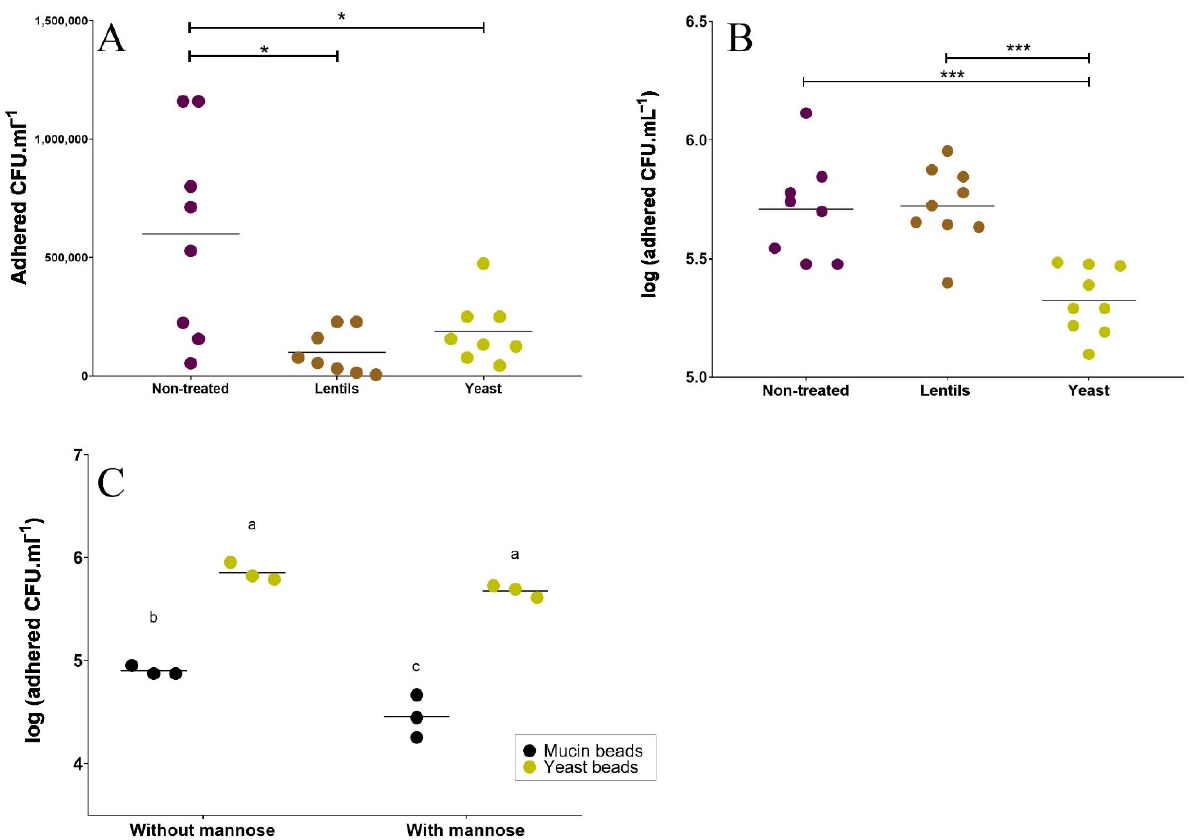
Figure 3. Effects of fiber-containing products on ETEC adhesion on mucin and mucus-secreting intestinal cells. ( A , B ) The impact of the lentil extract (brown, ‘lentils’) and specific yeast cell walls (yellow, ‘yeast’) on ETEC adhesion (initial concentration: 10 7 CFU · mL − 1 ) was investigated using two different in vitro assays and compared to the non-treated control condition (purple). ( A ) ETEC adhesion to mucin beads after a 1 h infection period. Results are expressed as adhered cells (CFU · mL − 1 ). ( B ) ETEC adhesion to Caco-2/HT29-MTX co-culture model after a 3 h pre-treatment with fiber-containing products followed by an additional 3 h infection period. Results are expressed as adhered cells (Log 10 CFU · mL − 1 ). Figures represent all technical replicates from three independent experiments, and means are indicated by black bars. Indicated p -values were provided by Tukey’s multiple comparisons tests (*: p < 0.05, ***: p < 0.001). ( C ) Adhesion of ETEC strain H10407 (initial concentration: 10 7 CFU · mL − 1 ) on specific yeast–alginate beads (yellow dot) or mucin–alginate beads (black dot), with or without mannose (10 g · L − 1 ). Each point represents one of three independent biological replicates and means are indicated by black bars. Results that are not different from each other according to Tukey’s multiple comparisons tests are grouped under the same letter ( p < 0.05).